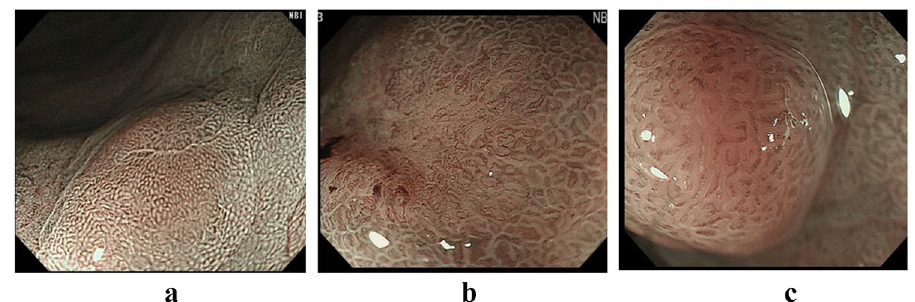
Figure 2. ( a ) Is a representative case of gastric adenoma with 100% accuracy in M-NBI correctly diagnosed by all endoscopists. ( b ) Is a representative case of gastric cancer correctly diagnosed by all endoscopists. ( c ) Is a representative case of gastric cancer correctly diagnosed by only 21% of